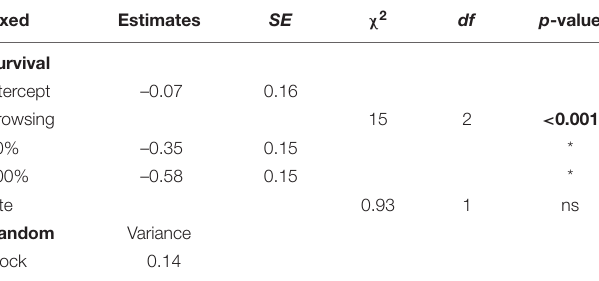
TABLE 3 | ANOVA (type II test) and summary table for generalized linear mixed effects models testing the difference in sawfly survival in relation to browsing intensity (un-browsed, 50 and